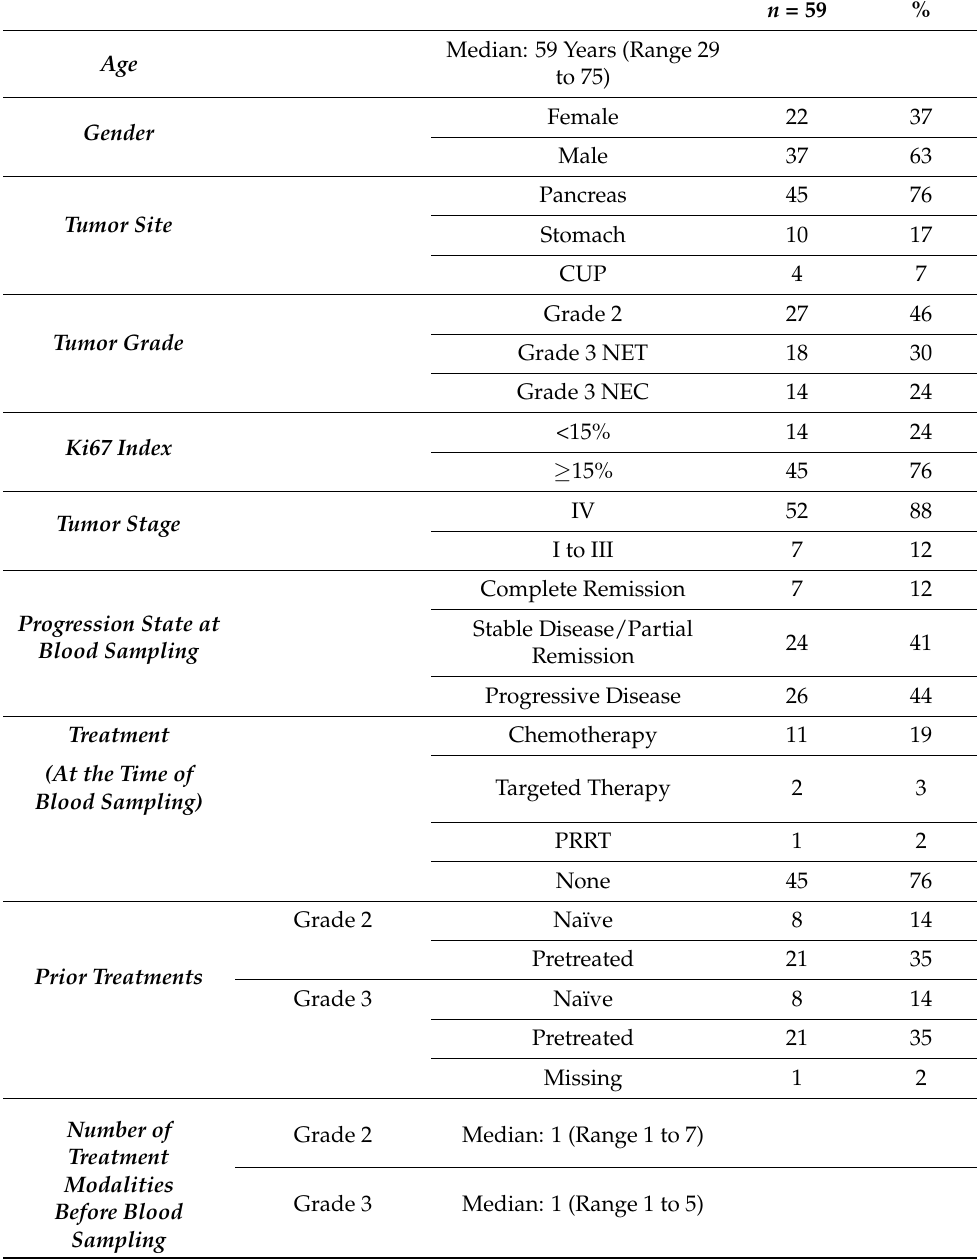
Table 1. Clinical characteristics of the cohort for determination of circulating Flt3L. Characteristics of the serum samples used for determination of circulating Flt3L. Tumor stage refers to AJCC staging criteria. Samples included longitudinal measurements in 9